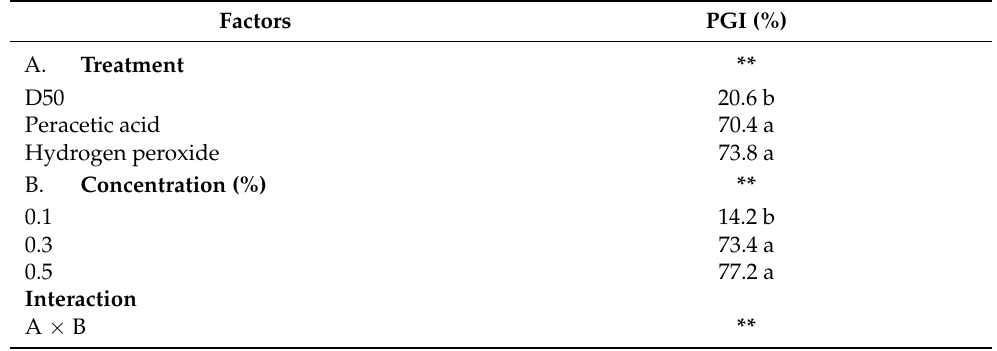
Table 5. Analysis of variance of PGI (%) at the end of the in vitro trial with chemical disinfectants. Three products (D50, peracetic acid and hydrogen peroxide) at three different concentrations (0.1%, 0.3% and 0.5%) were tested on inoculated PDA plates. Different letters indicate significant differences according to Tukey’s test ( p < 0.01).